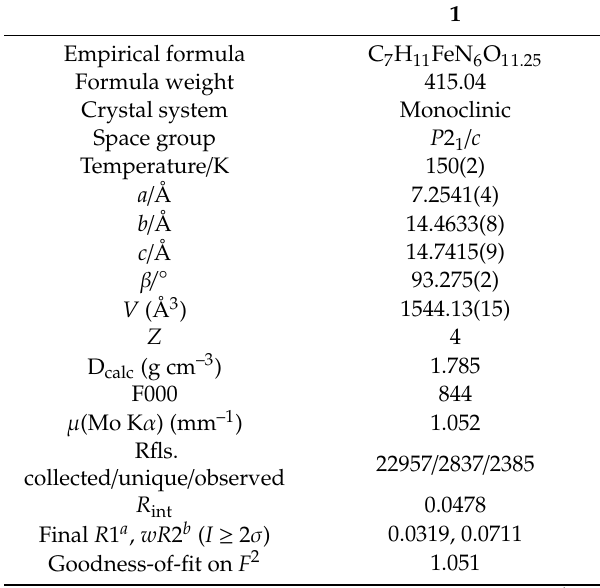
Table 1. Crystallographic parameters and structure refinement data for complex 1 .